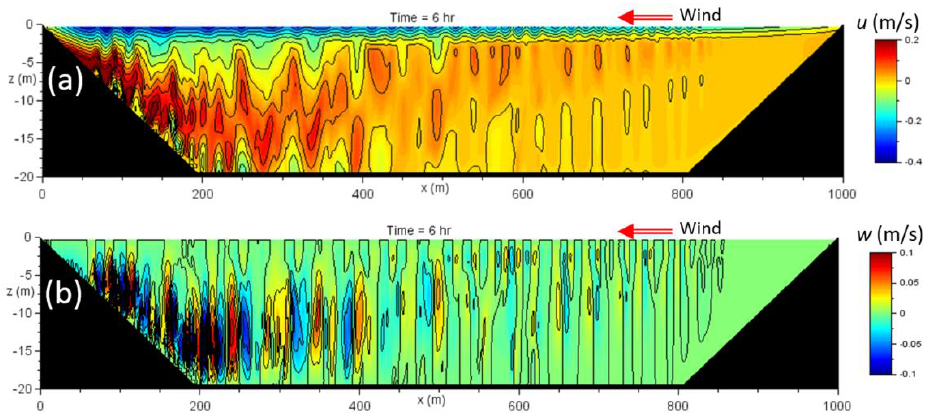
Figure 5. Scenario A ( N = 0) with τ x = −0.1 Pa. Shown are the distributions of ( a ) horizontal velocity u and ( b ) vertical velocity w after 6 h of simulation.